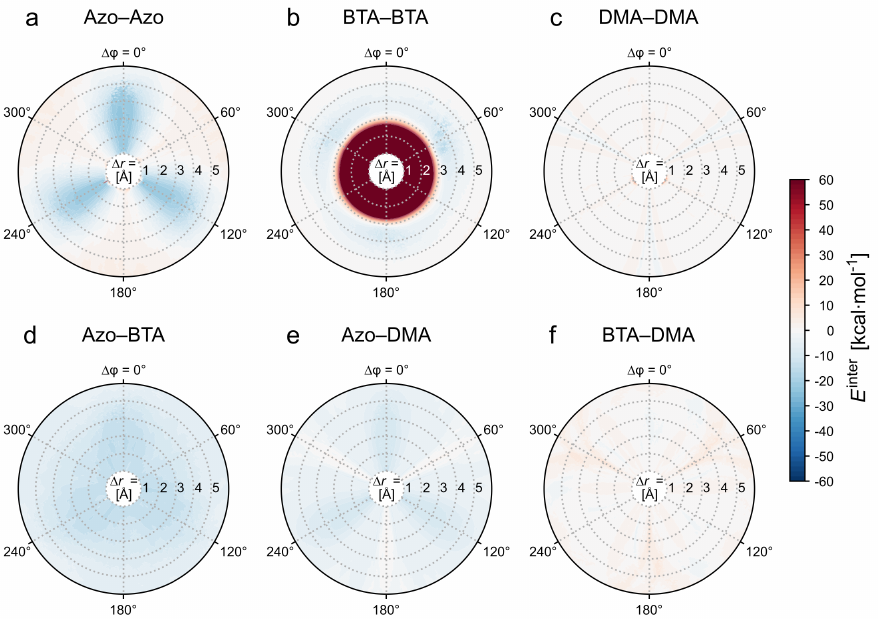
Figure 4. Decomposition of the intermolecular energy of a TrisAzo dimer by the interactions arising between different parts of the molecules. Upper row: Interactions between corresponding compo- nents, ( a ) Azo–Azo, ( b ) BTA–BTA, and ( c ) DMA–DMA. Lower row: Interactions between mixed components, ( d ) Azo–BTA, ( e ) Azo–DMA, and ( f ) BTA–DMA. All plots use the same energy scale. The color scheme corresponds to the one in Figure 2b. The absence of data for ∆ r < 1Å is indicated by an empty (white)